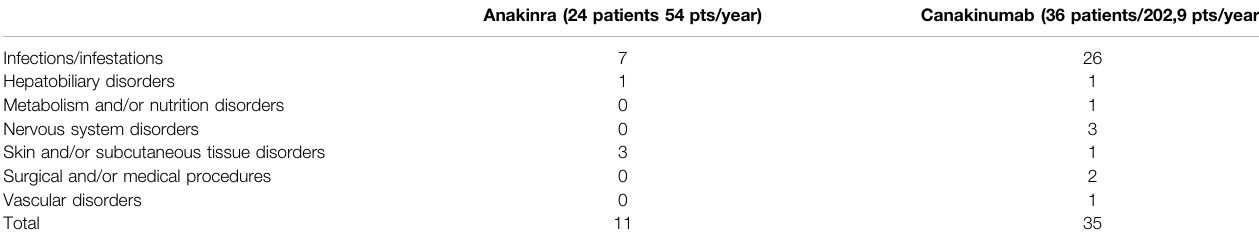
TABLE 2 | Reported side effects with IL1 inhibitors during the study period.